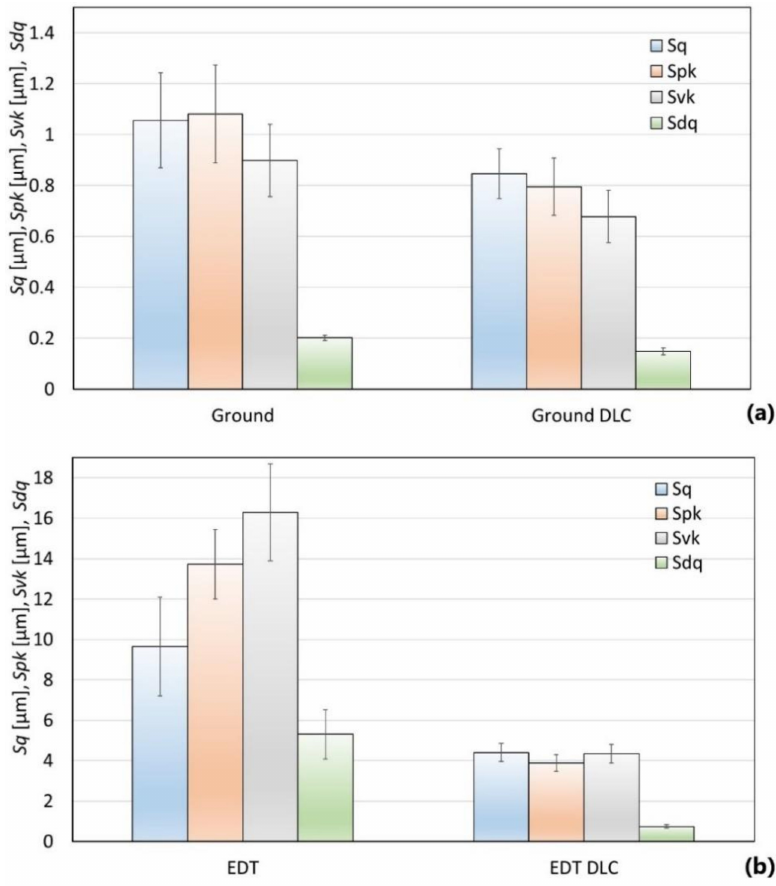
Figure 4. Sq, Spk, Svk and Sdq values: ( a ) ground condition; ( b ) EDT